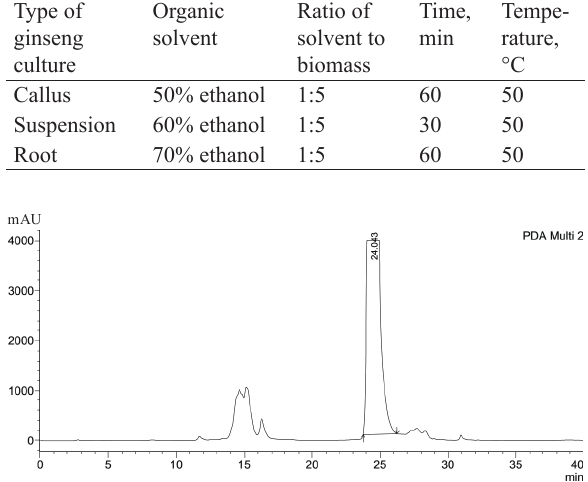
Figure 5 Qualitative analysis of ginseng flavonoids